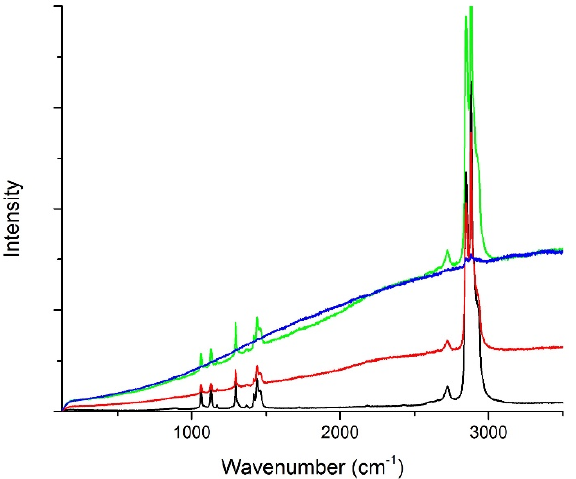
Figure 5. Raman spectra using 475 nm excitation of gamma-irradiated PE in fresh water (red trace), salt water (green trace), and Lake Michigan water (blue trace) show substantial fluorescence in comparison to the stock PE (black trace).